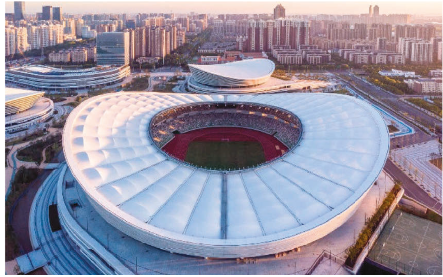
Figure 2: The appearance of the stadium.